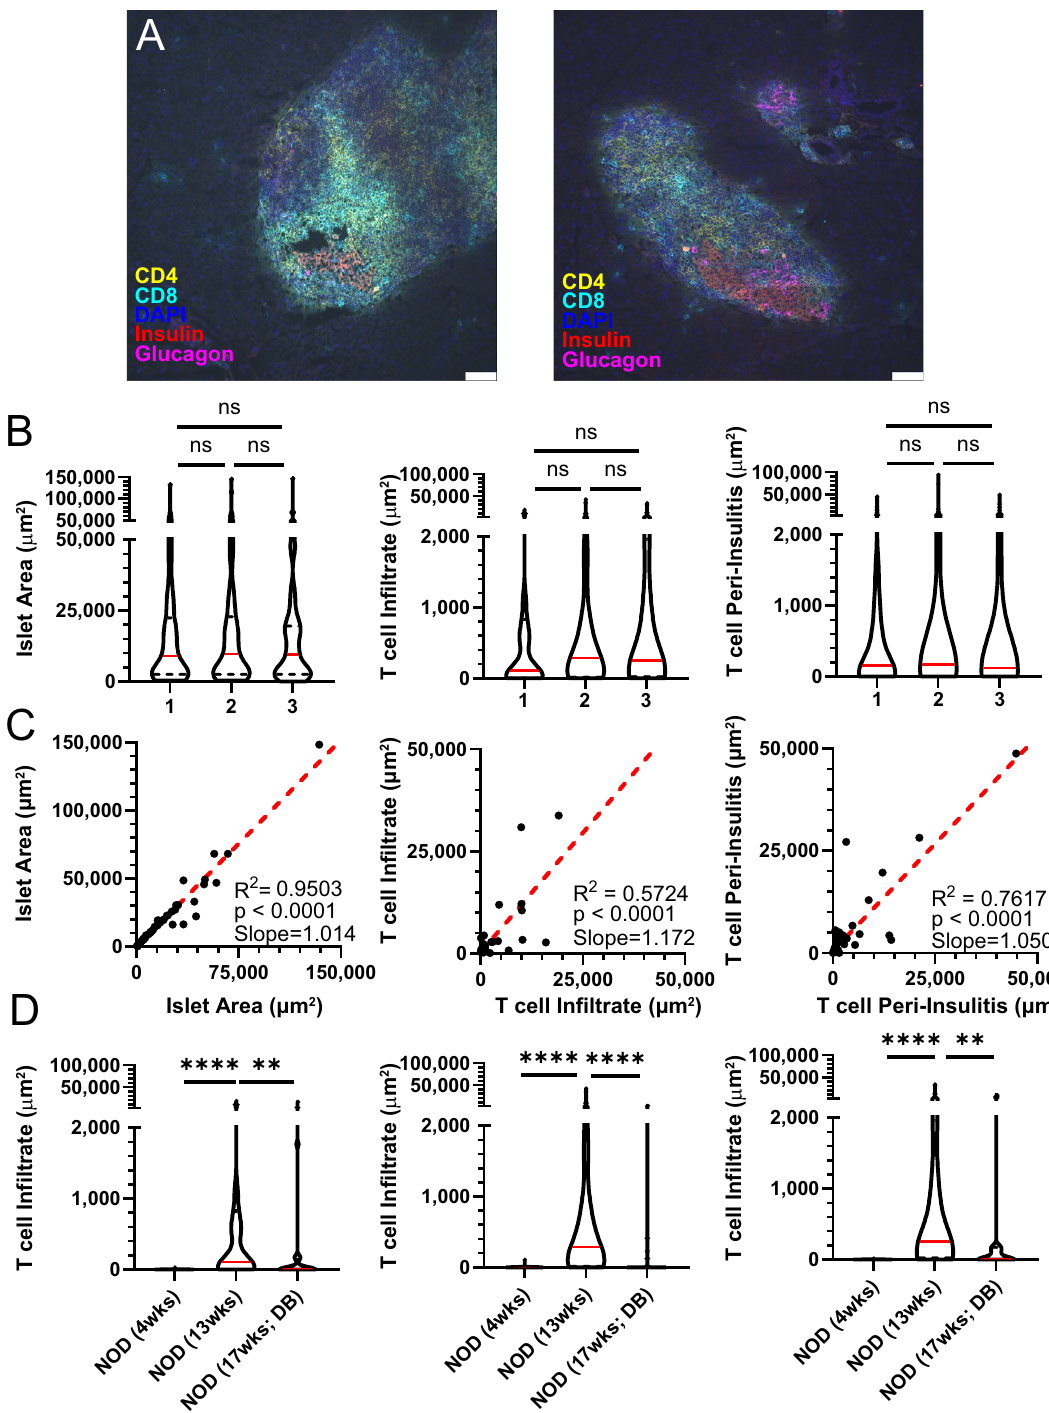
Figure 8. Quantitative islet analysis yields reproducible data when performed by multiple independent analyzers. ( A ) Histology images of two representative 13-week-old non-diabetic NOD mouse islets with CD4 (yellow), CD8 (cyan), DAPI (blue), insulin (red) and glucagon (magenta) staining showing heavily infiltrated islet with islet borders that are difficult to define (yellow stars). ( B – D ) A randomly selected subset of islet images (n = 66) obtained from 4-week, 13-week non-diabetic and 17-week diabetic NOD mice (n = 3/group) were separately assessed using the quantitative methodology by three independent and blinded analyzers. ( B ) Islet area, T cell infiltration and T cell peri-insulitis of individual islets pooled from all mice of a given age as assessed by analyzers 1–3. ( C ) Linear regressions of islet area, T cell infiltration and T cell peri-insulitis between analyzers 1 (x-axis) and 2 (y-axis). ( D ) Combined CD4 + and CD8 + T cell infiltration of different NOD mouse timepoints as assessed by analyzers 1–3. White bars on histology images represent 50 μm length. Dotted red lines on linear regression plots represent the line of best fit. Solid red lines on violin plots depict the median and dotted black lines depict the first and third quartiles. “DB” refers to diabetic mice. Kruskal–Wallace test with post-hoc Dunn’s multiple comparison test was performed to determine statistical significance. Data are representative of three independent experiments. * p < 0.05, ** p < 0.01, *** p < 0.001, **** p < 0.0001. ns not